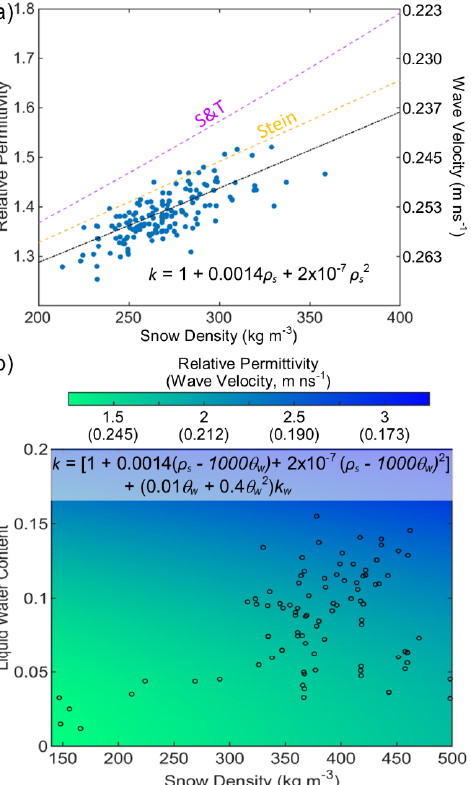
Figure 4. Results of in situ data comparisons for ( a ) dry snow with Sihvola and Tiuri [31] (ST) and Stein et al. [47] shown for comparison to our regression line; and ( b ) for calorimeter-based liquid water content observations.